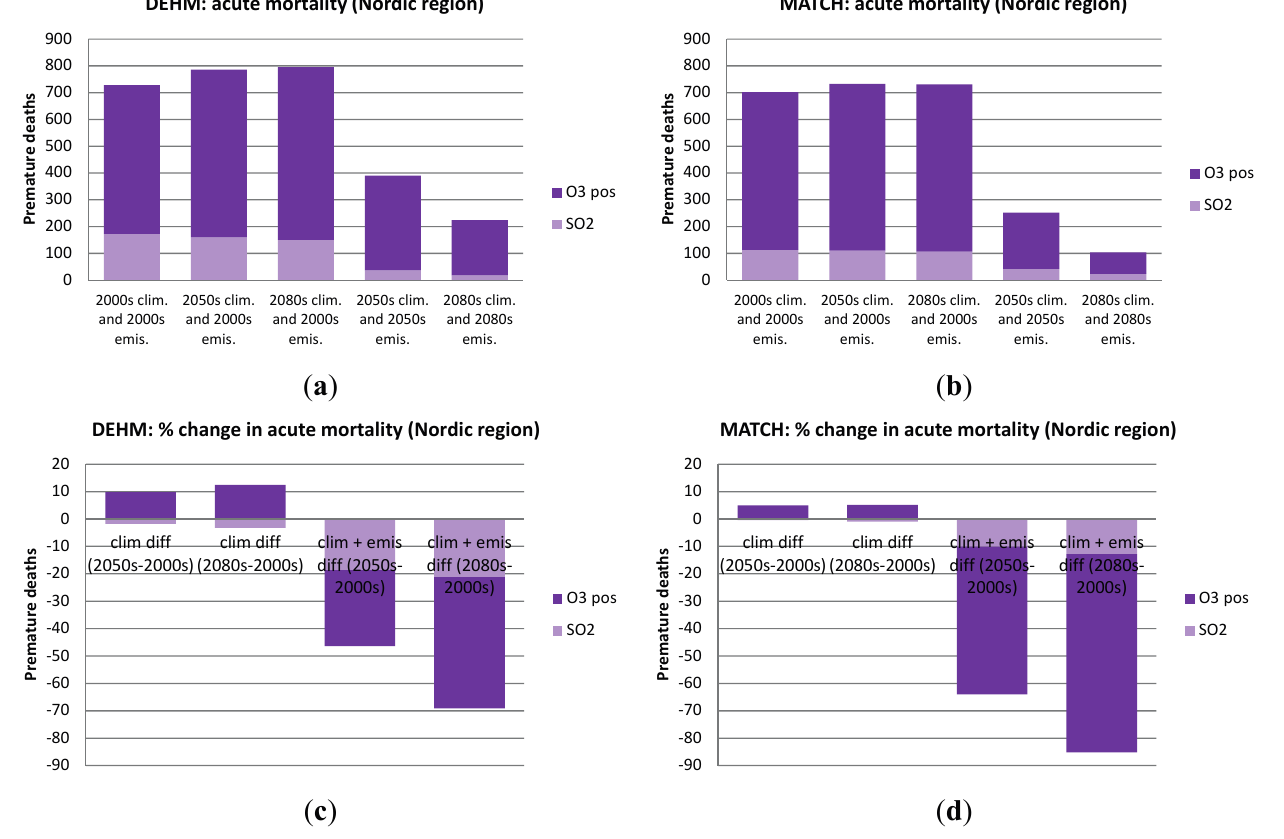
Figure 6. As in Figure 4, but for the Nordic region only (Sweden, Finland, Norway and